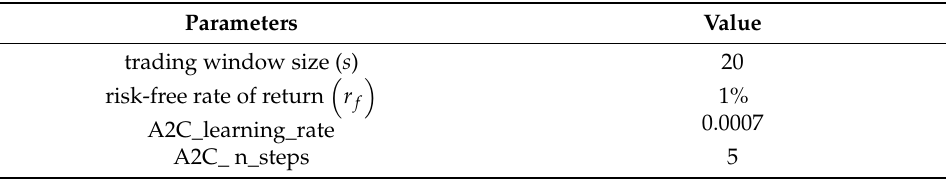
Table 3. Summary of RL agent’s parameters.